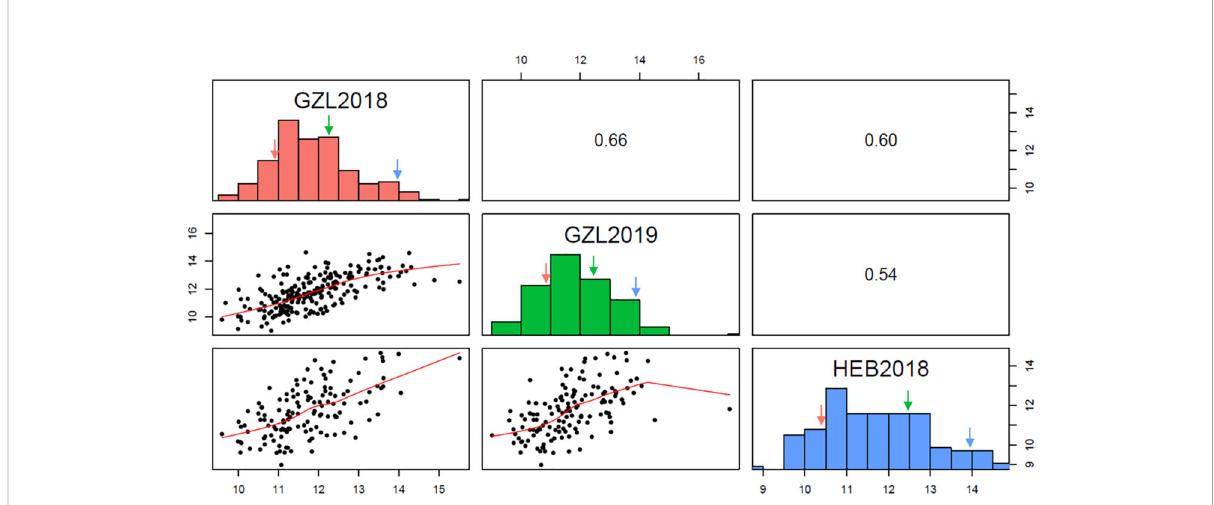
FIGURE 1 Frequency distribution of protein content (PC) and correlations across three environments. GZL2018, GZL2019, and HEB2018 indicate Gongzhuling in 2018, Gongzhuling in 2019, and Harbin in 2018, respectively. Red arrow: Ye3189; blue arrow: Ji846; blue arrow: